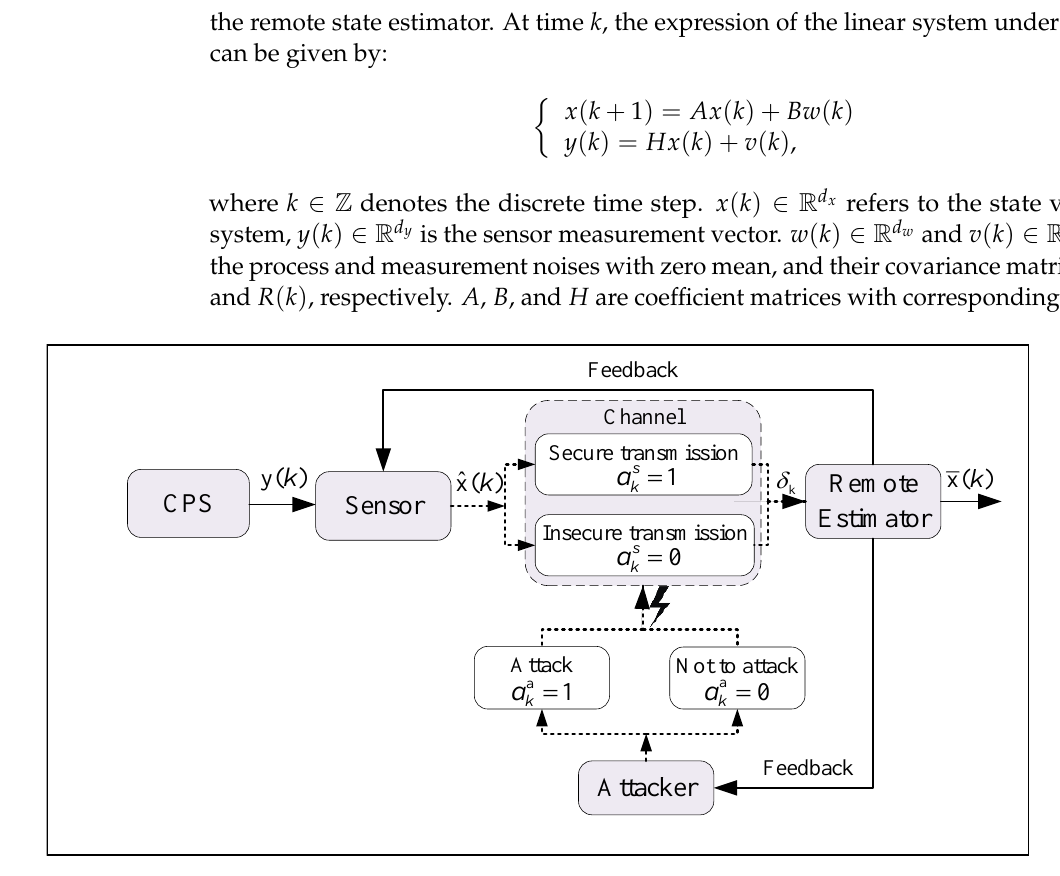
Figure 1. Remote security estimation over wireless channel under DoS